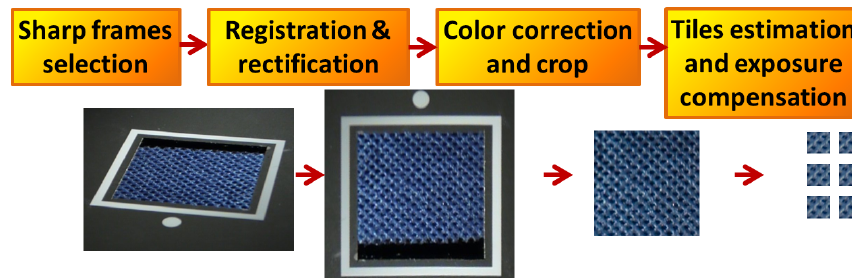
Figure 4. The pipeline of each slice’s frame